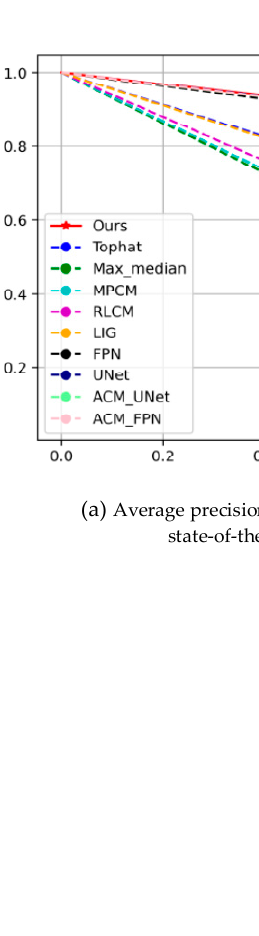
Figure 5. Performance of state-of-the-art methods on the SIRST dataset: ( a ) PR curve, ( b ) area under the ROC curve, and ( c ) F-area.